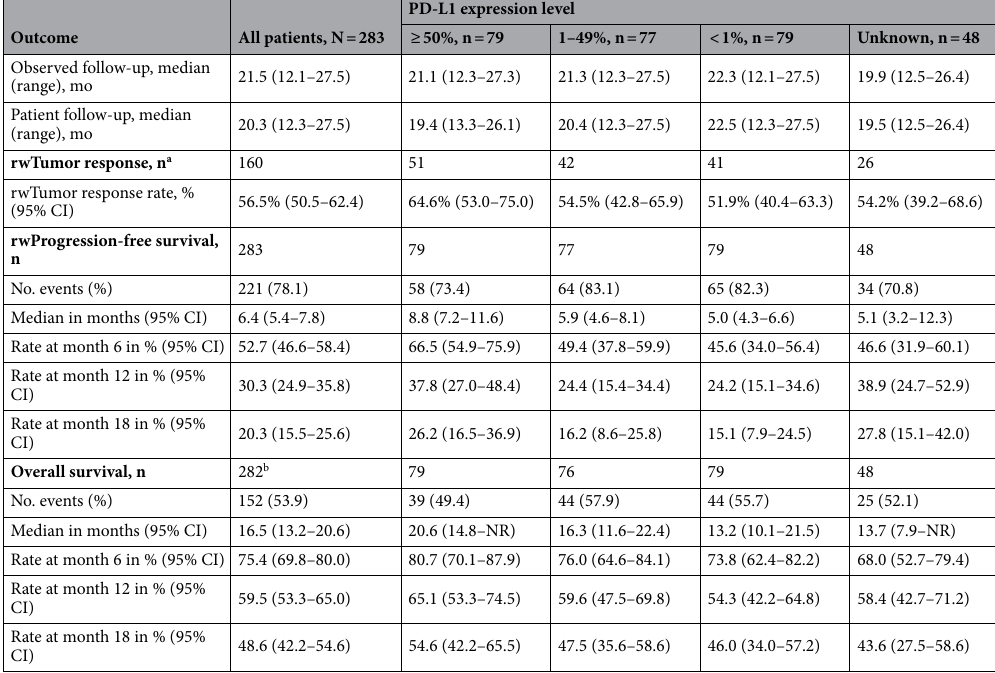
Table 2. Real-world outcomes of first-line pembrolizumab plus pemetrexed-carboplatin. Observed follow-up was defined as the time from pembrolizumab initiation to database cutoff. Patient follow-up was defined as time from pembrolizumab initiation to the date of death or data cutoff, whichever occurred first. Mo month, NR not reached. a Real-world tumor response (rwTR) was defined as complete response or partial response. b One patient was excluded for negative OS value when setting the date of death to the 15th of the month.